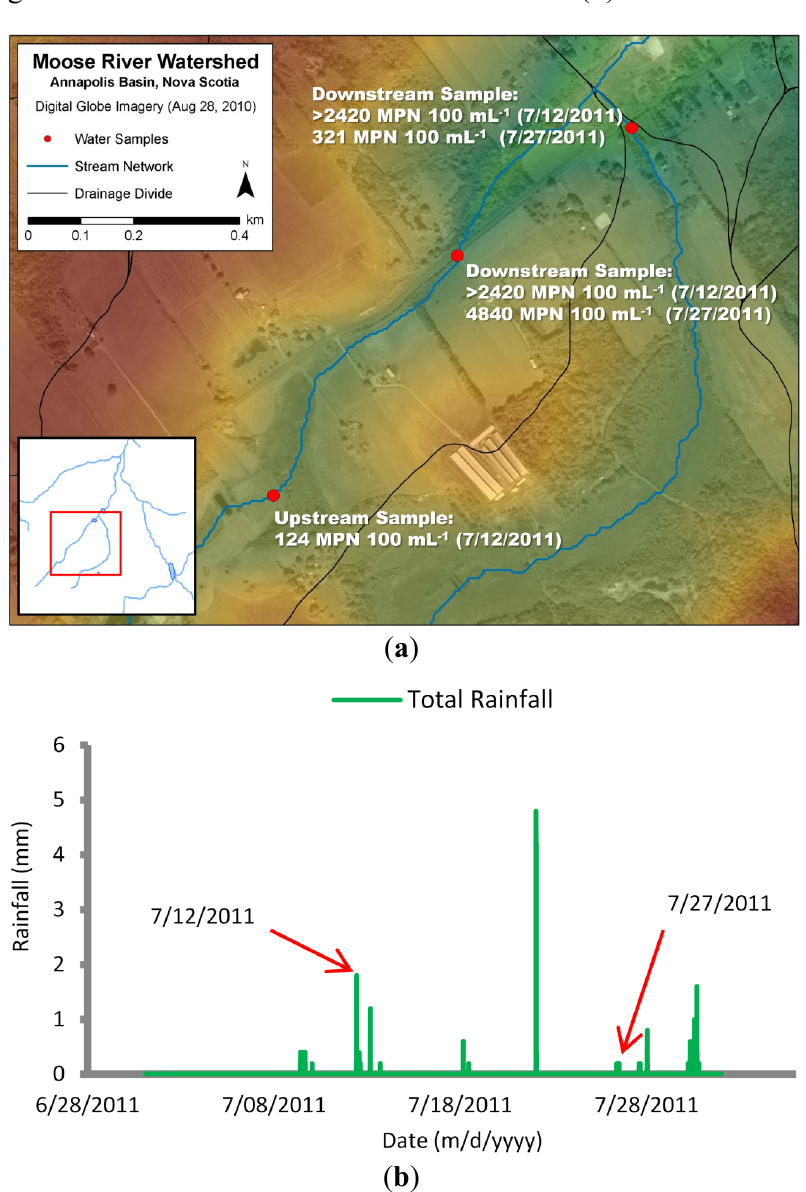
Figure 4. Water sample locations upstream and downstream of mink farm site (elevations represented by color—higher elevation: red/yellow; lower elevation: green/blue) ( a ); with corresponding total rainfall from Bear River weather station ( b